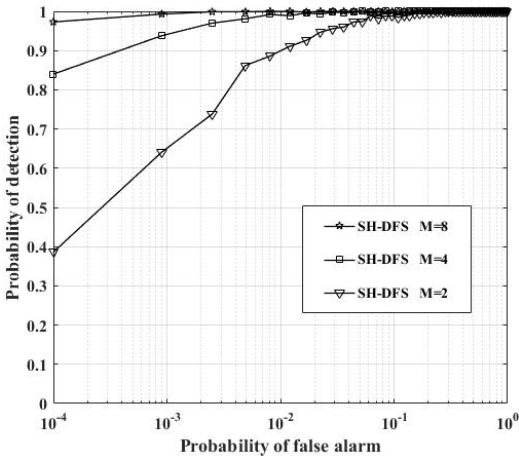
Figure 15. The probability of detection of the clustered distributed system with SH-DFS at a different cluster number versus the global desired probability of false alarm at the FC.